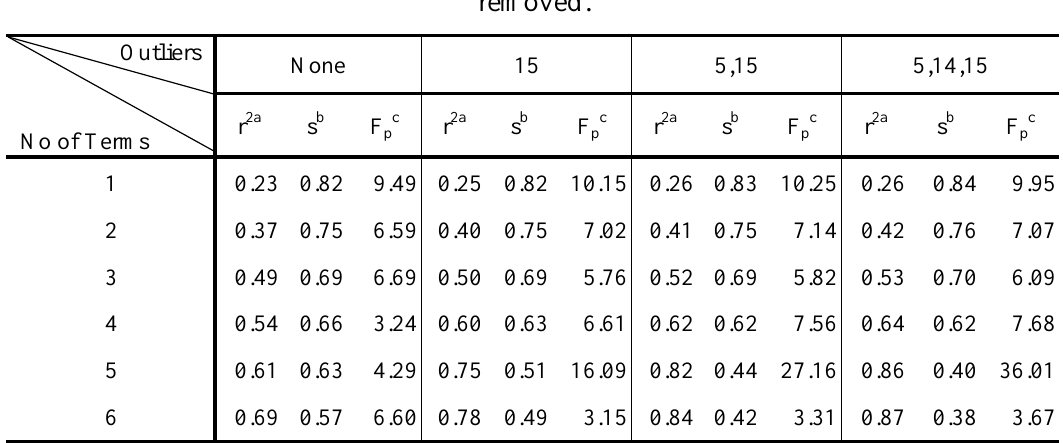
Table 1. Improvement of the best QSAR equation in relation to the number of terms and outliers removed.